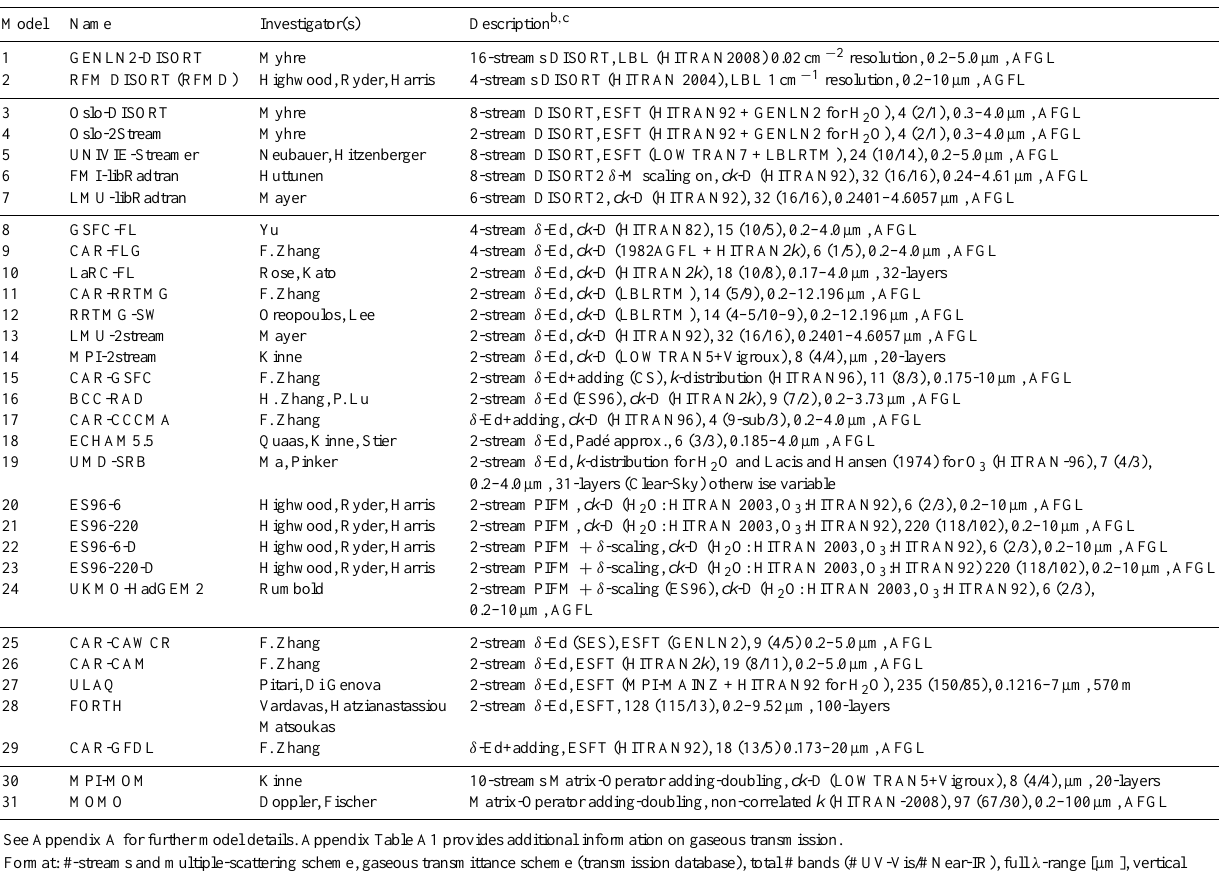
Table 1. Models, investigators, and description